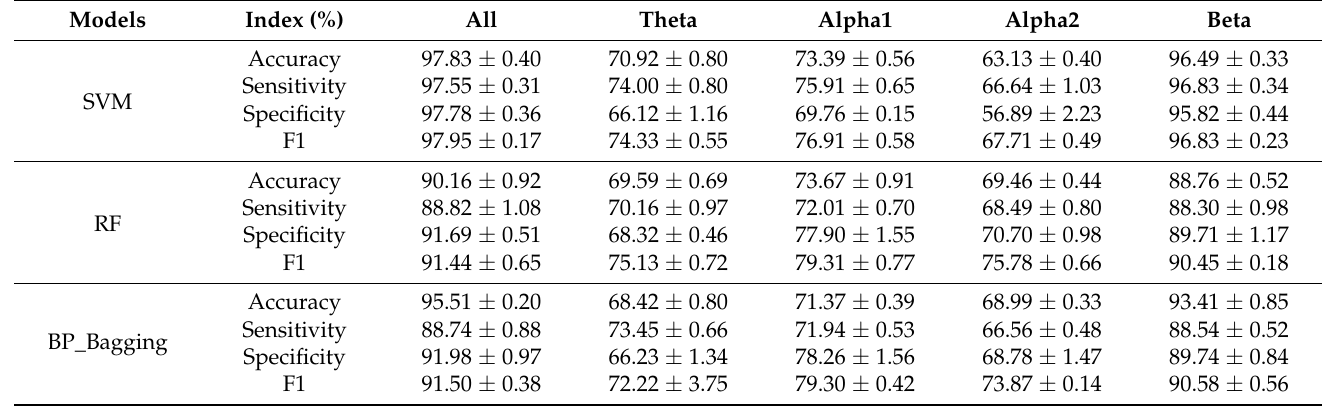
Table 2. Classification accuracies with different feature groups between GAD and HC.